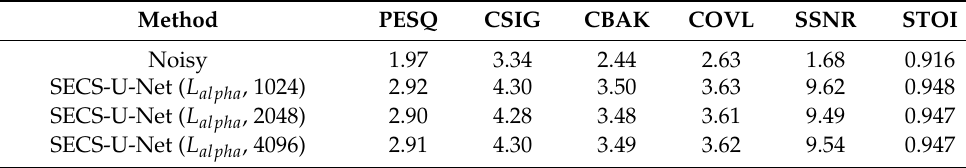
Table 1. Influence of different measurement